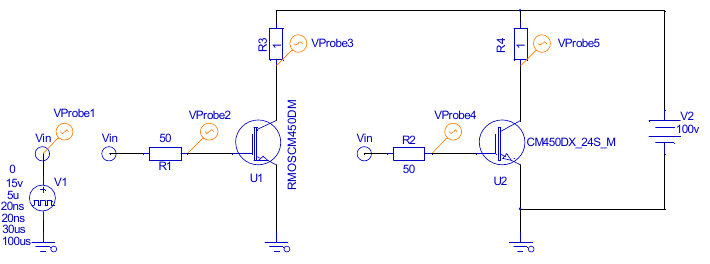
Figure 19. CM450DX-24S modeling test schematic. This model uses the same exponential function of impedance change as in the previous simple